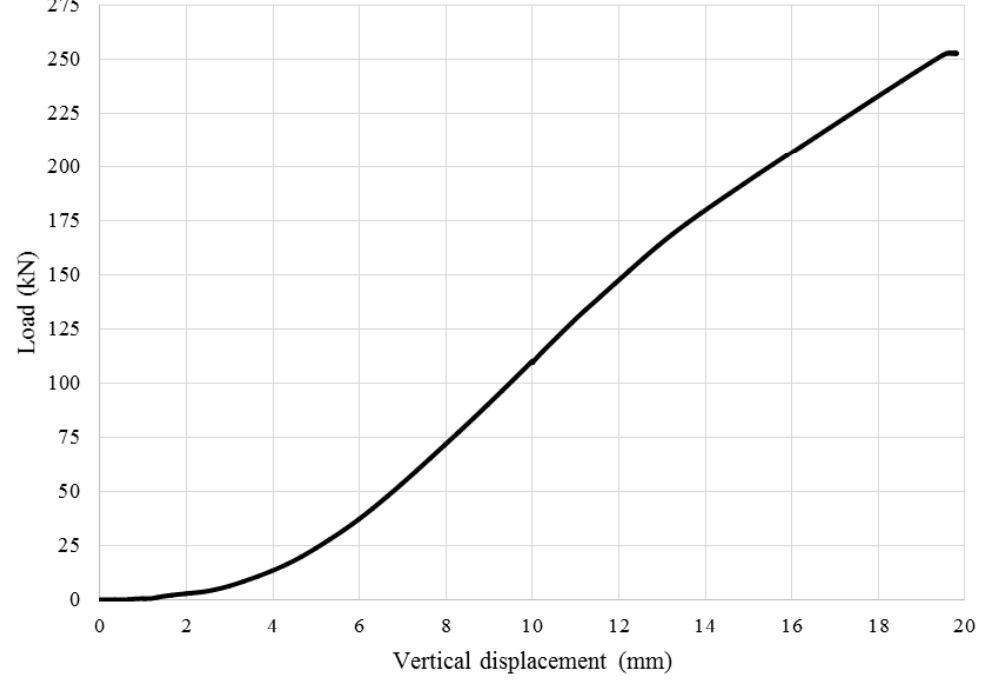
Figure 14. Load-displacement curve of test beam test-B.